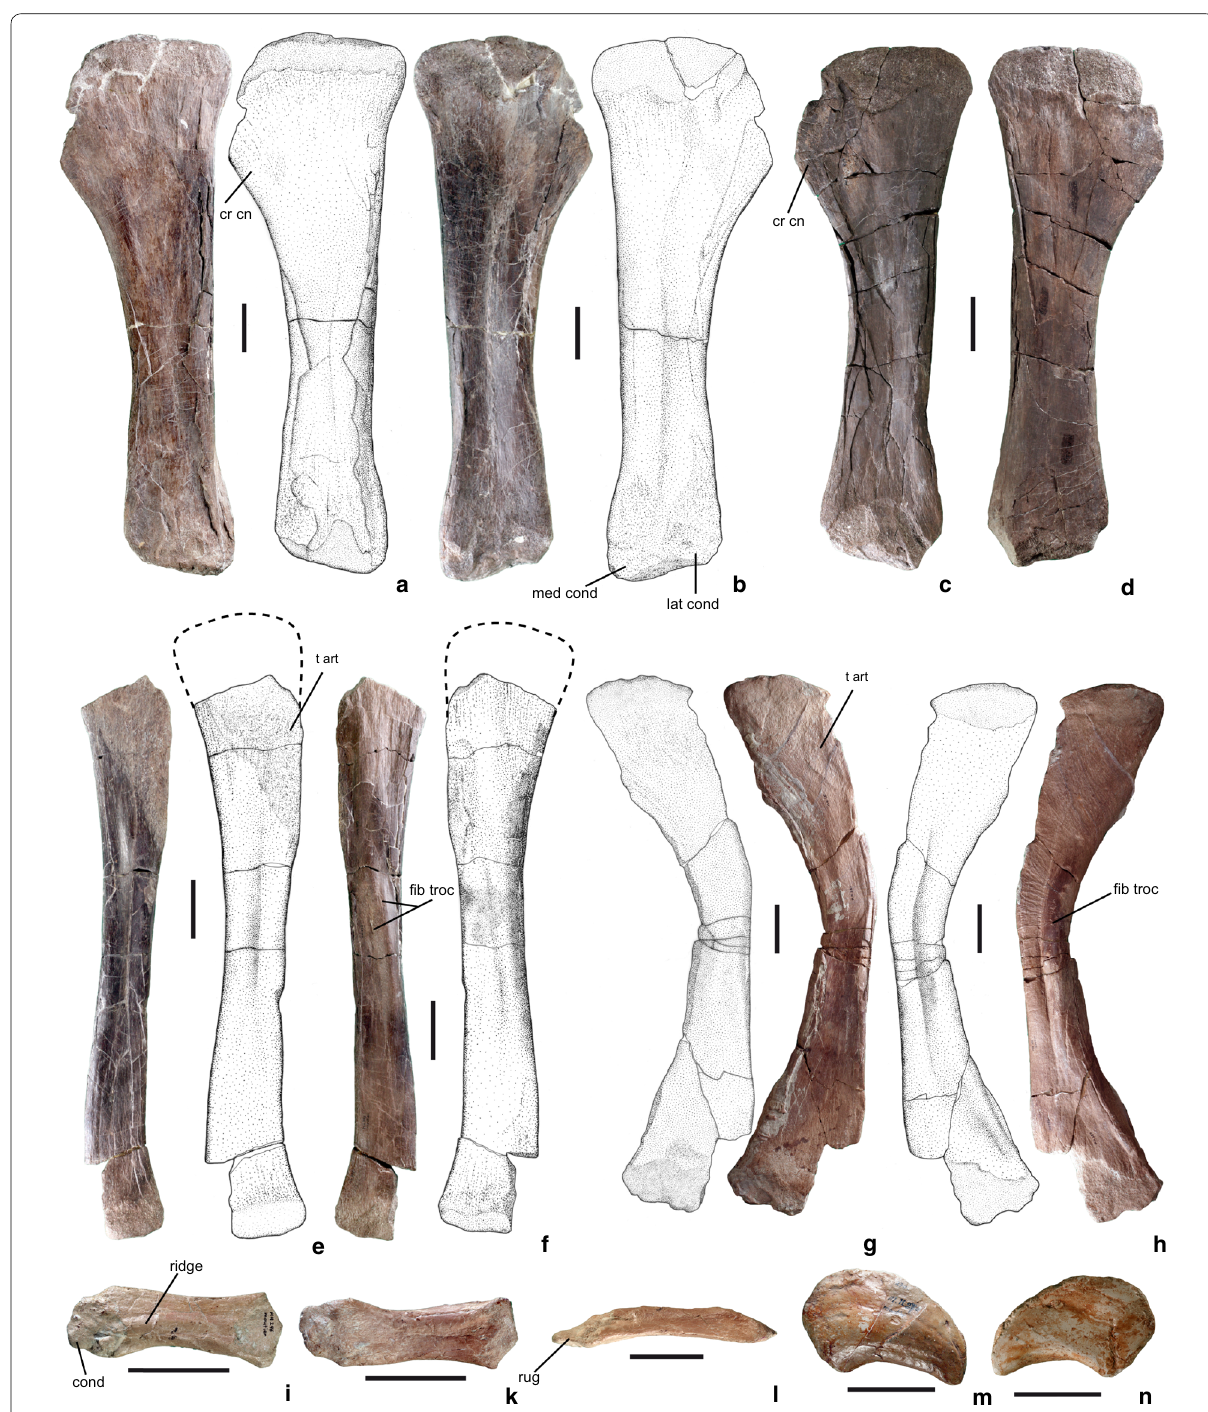
Fig. 13 Elements of crus and pes of A. greppini . Left tibia NMB M.H. 342 as photograph and interpretative drawing in a posterior and b anterior aspect. Right tibia NMB M.H. 339 in c anterior and d posterior aspect. Left fibula NMB M.H. 373 as photograph and interpretative drawing with reconstructed supposed outline of fibular head (hatched line) in e medial and f lateral aspect. Photograph and interpretative drawing of left fibula NMB M.H. 387 in g lateral and h medial aspect. Presumed 4th metatarsal NMB M.H. 246 in i dorsal, k ventral and l lateral aspect. Cast of pedal ungual phalanx NMB M.H. 270 m in lateral aspect and n in medial aspect. Scale bar is 50 mm. Drawings by Serafin Padzera. cond condyle, cr cn cnemial crest, fib troc fibular trochanter, lat cond lateral condyle, med cond medial condyle, rug rugosity, t art tibial articular surface of